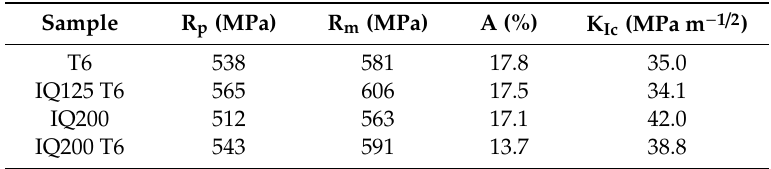
Figure 2. Mechanical properties of the alloy in different heat treatment conditions. Table 2. Mechanical properties in the long transverse (LT) direction of the T6 reference and IQ-treated samples.